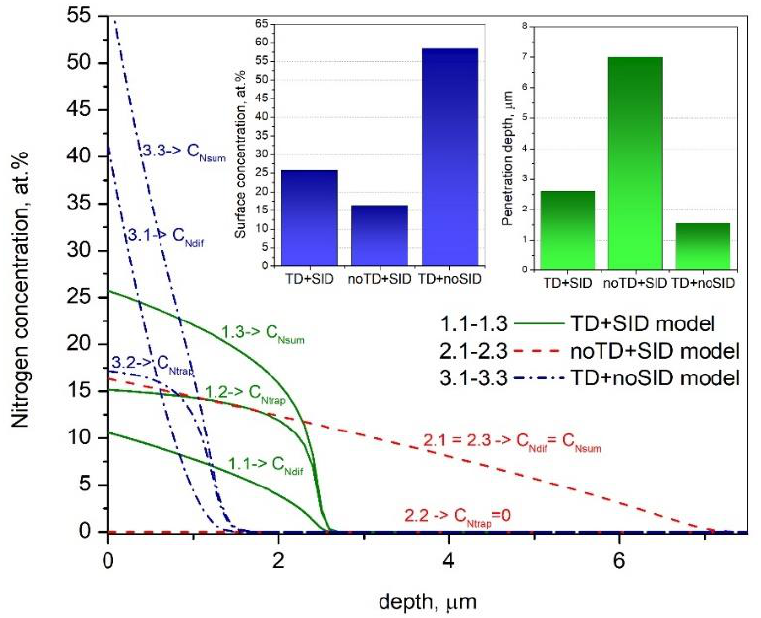
Figure 3. Calculated depth profiles of nitrogen ( C Nsum , C Ntrap and C Ndif ) for three cases: (1) including both processes trapping–detrapping (TD) and stress induce diffusion (SID) (curves 1.1–1.3), (2) only one process SID (curves 2.1–2.3) and (3) including only TD model (curves 3.1–3.3.).